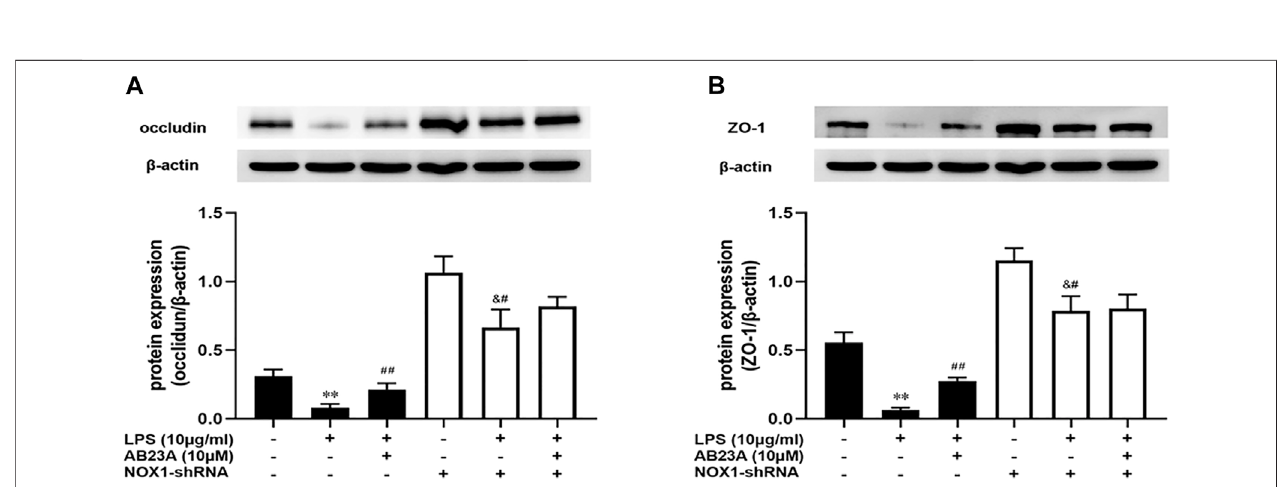
FIGURE 8 | AB23A effects on the intestinal barrier permeability induced by LPS in association with the inhibition of NOX1/ROS. Following transfection with NOX1 shRNA, the cells underwent treatment with or without LPS and AB23A for 12 h. (A) The occludin and ZO-1 protein expression levels. (B) ZO-1 protein expression level. All gel images are from the same sample. β -actin was utilized repeatedly as a control image. ** p < 0.01 vs. control; ## p < 0.01 vs. LPS (10 μ g/ml); &# p < 0.01 vs. NOX1- shRNA.